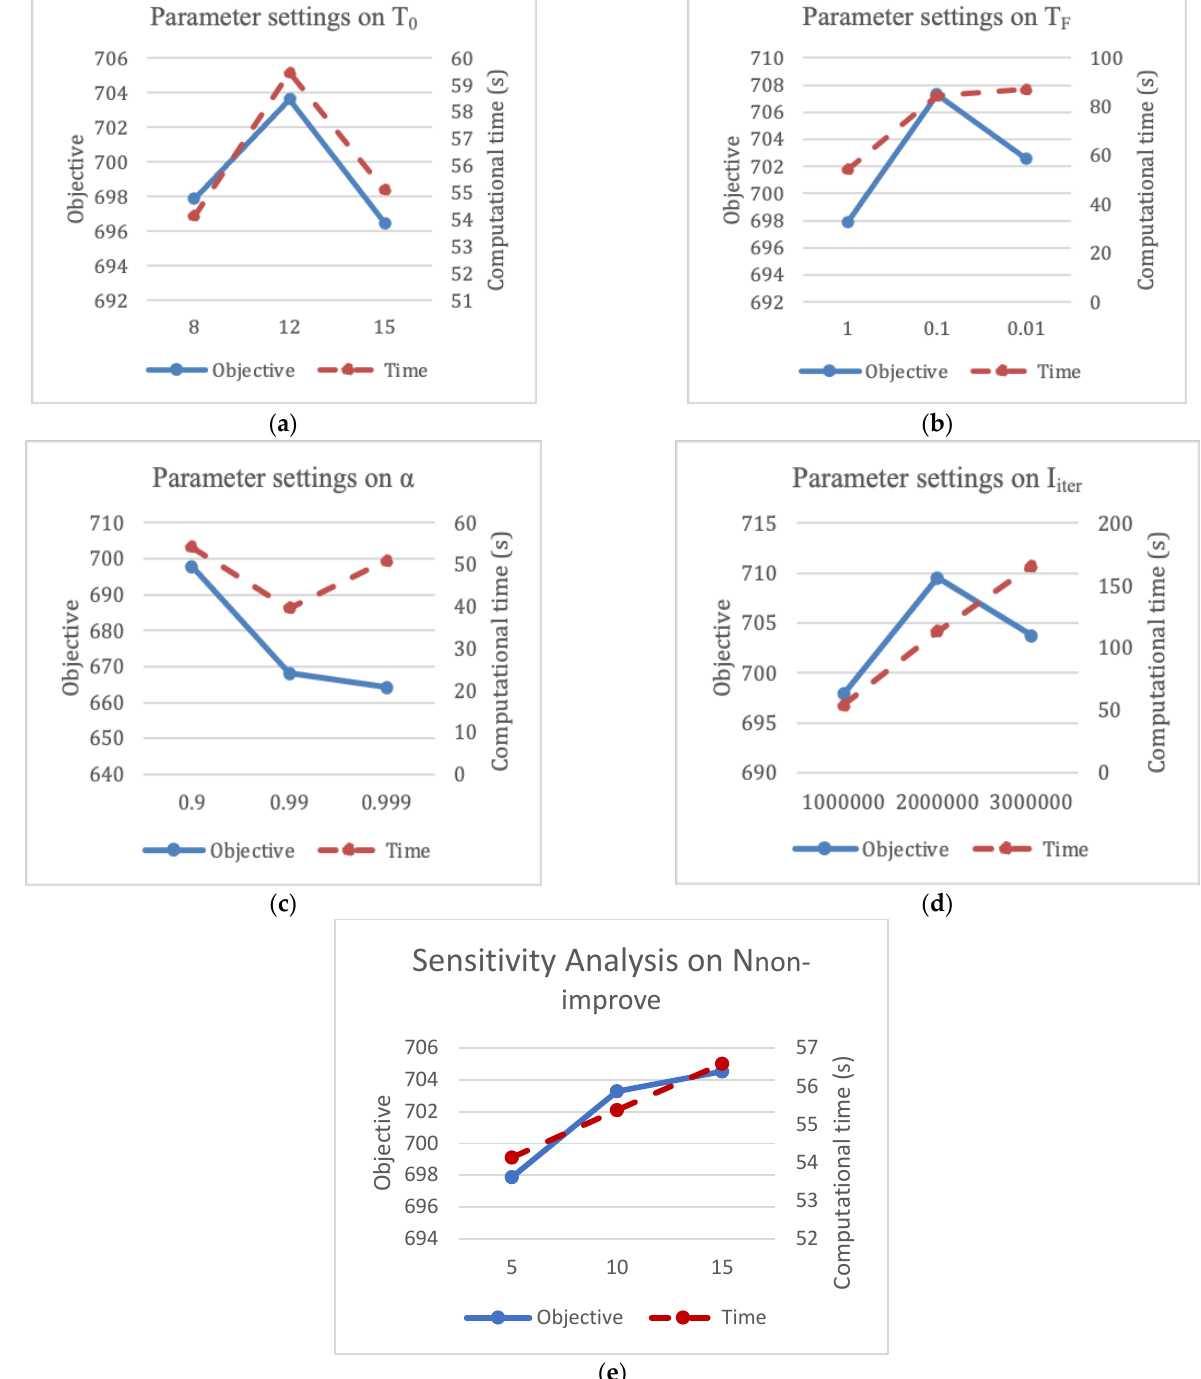
Figure 5. The impact of simulated annealing parameters on the quality of share-a-ride problem with flexible compartments solution and computational time on ( a ) T 0 parameter, ( b ) T F parameter, ( c ) α parameter, ( d ) I iter parameter, and ( e ) N non-improving parameter .